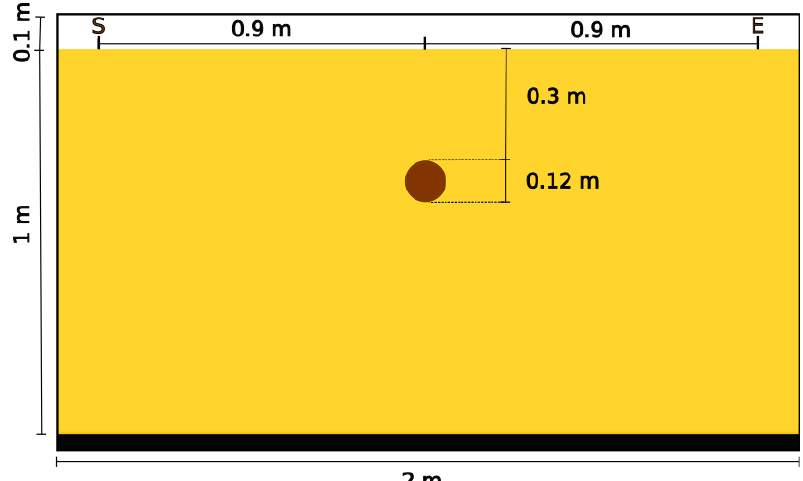
Figure 3. Geometry of the first model used for gprMax simulations. A 0.1 m layer of air (white) overlies a homogeneous material (yellow colored) with 0.19 m/ns velocity, in which a 0.06 m radius cylinder (brown) characterized by a velocity of 0.11 m/ns is embedded at 0.3 m depth. A 0.05 m PEC layer (in black) is placed at the bottom of the model. Traces are simulated by considering antennas moving every 5 cm from point S to E.